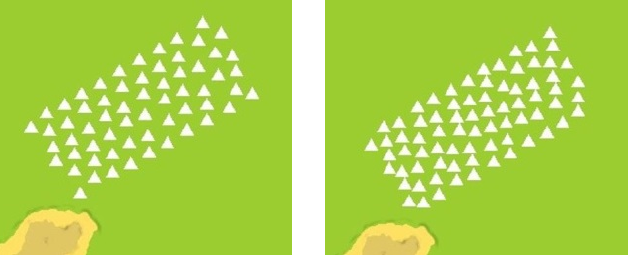
Figure 12. Symmetric ( left ) and asymmetric ( right ) wind farm layout off Wetar Island. Table 5. Number of turbines in a wind farm off Wetar Island calculated by WindSim Park Optimizer. Area Turbine A Turbine B Turbine C